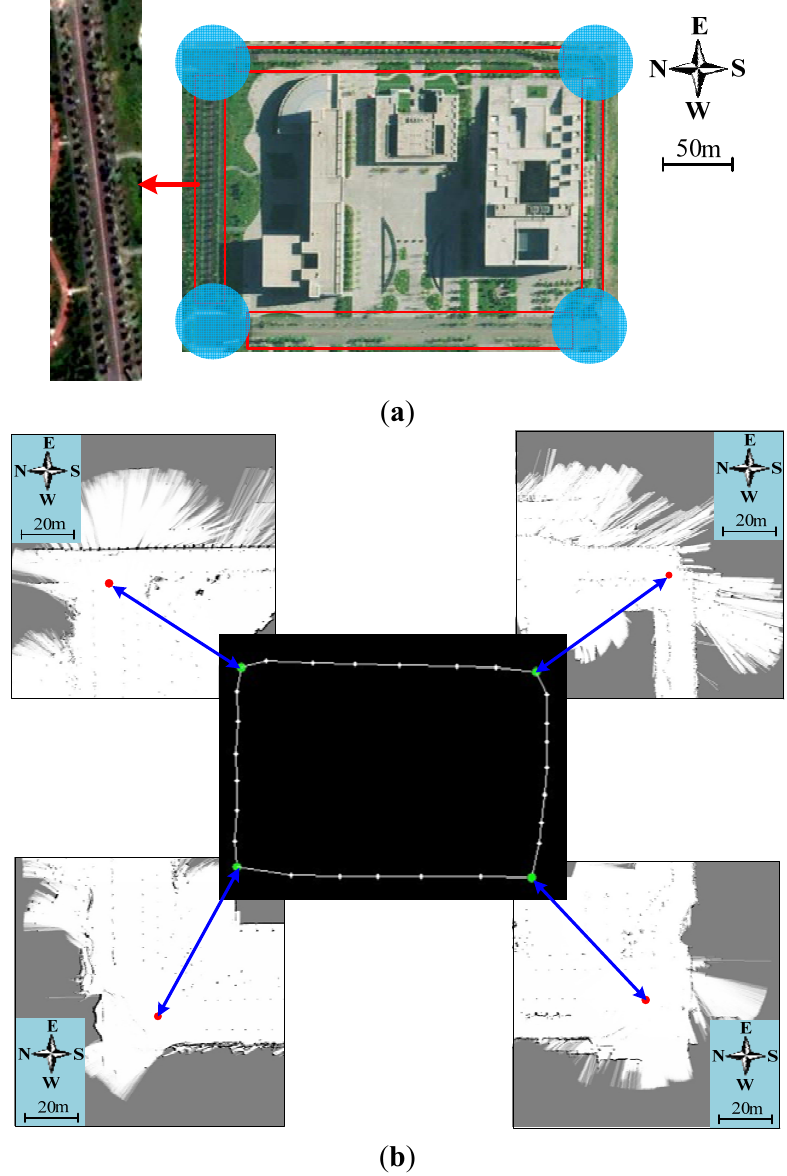
Figure 9. Metric-topological-based hybrid map of experiment environment. ( a ) Experiment scenario. The loose constraint areas include 4 intersections in blue circles, and the strong constraint areas include the roads in the red rectangles. ( b ) Hybrid map for unmanned ground vehicle navigation. The topological map constructed by GPS data is shown in the middle, with green points for intersections and white points on the road.